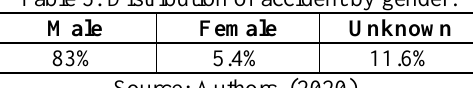
Table 5: Distribution of accident by gender.